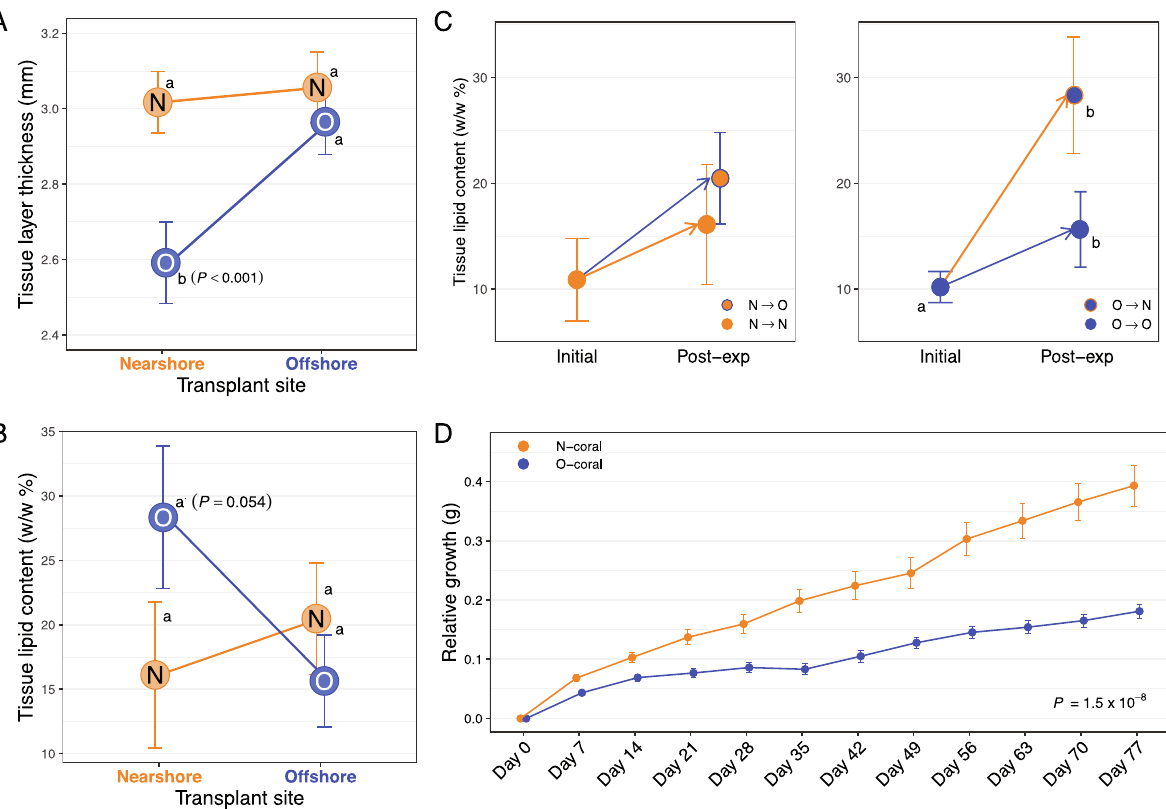
Figure 2. Physiological results of the 30-day reciprocal transplant experiment of P. lobata from N- and O-sites. (A) Tissue layer thickness, (B) tissue lipid content, and (C) short-term growth rate (starting weight adjusted to 6 g), (D) tissue lipid content before and after the experiment. Different letters indicate a statistically significant difference. Error bars denote standard